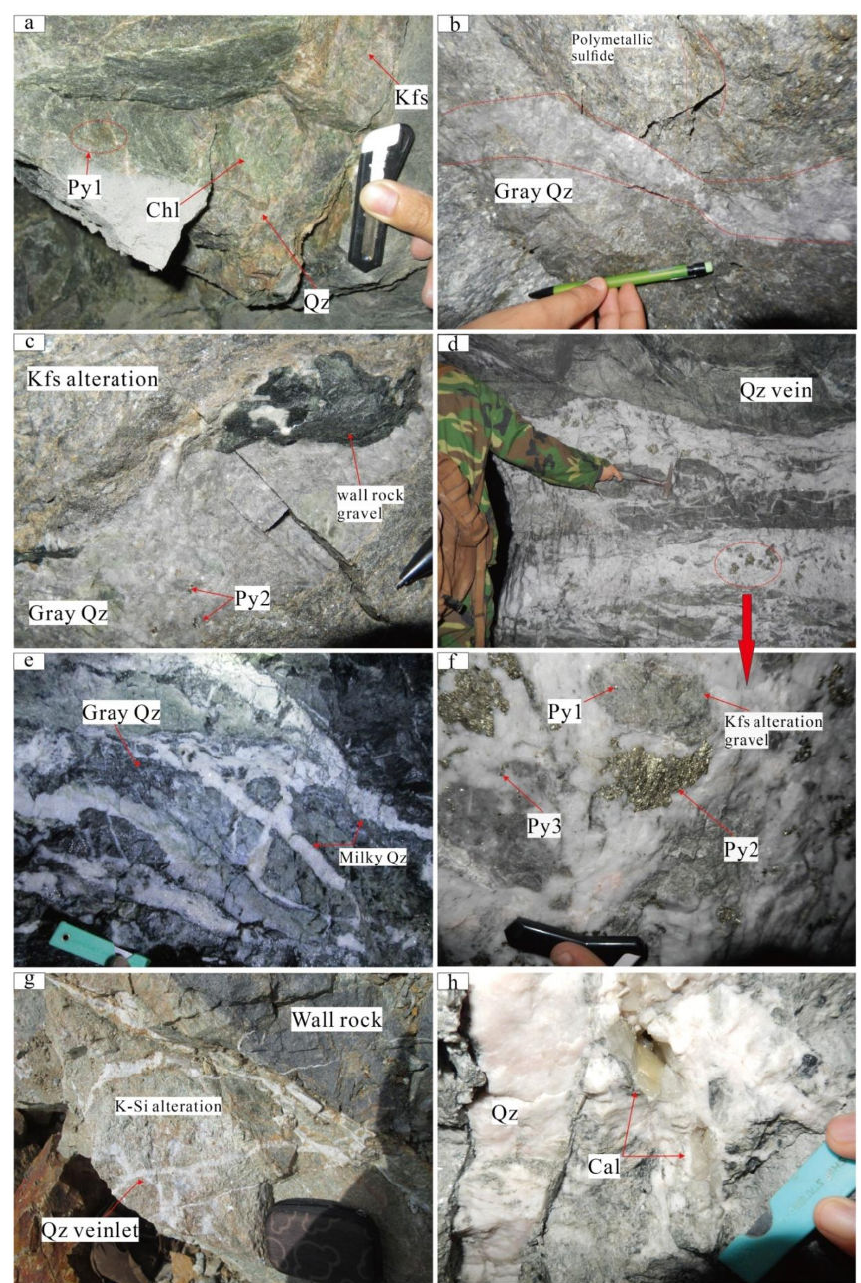
Figure 6. Photographs from underground and ground exposures in the Baiyun deposit. ( a ) K-feldspar altered zone, with coarse-grained K-feldspar, chlorite associated with alteration and, sporadically distributed pyrite and quartz. ( b ) Massive polymetallic sulfide in the silicification zone. ( c ) Pyrite presents as pyritohedron and coarse-grains in gray quartz. ( d ) A broad quartz vein of late silicification stage crosscuts the rock associated with early silicification in − 80 tunnel and contains breccias and massive pyrite. ( e ) Milky quartz stockworks crosscut the gray quartz formed in the early stage. ( f ) The photograph is enlarged from the red circle denoted on ( d ), Py1 was found in breccias of K-feldspar altered wall-rock. In the quartz vein, there are two distinct forms of pyrite, which are agglomerated Py2 and isolated Py3. ( g ) It is can be seen from the photograph of ground that the quartz veinlets crosscut the K-Si alteration. ( h ) Quartz-calcite vein in the latest mineralization stage. Py: pyrite; Chl: chlorite; Kfs: K-feldspar; Qz: quartz; Cal: